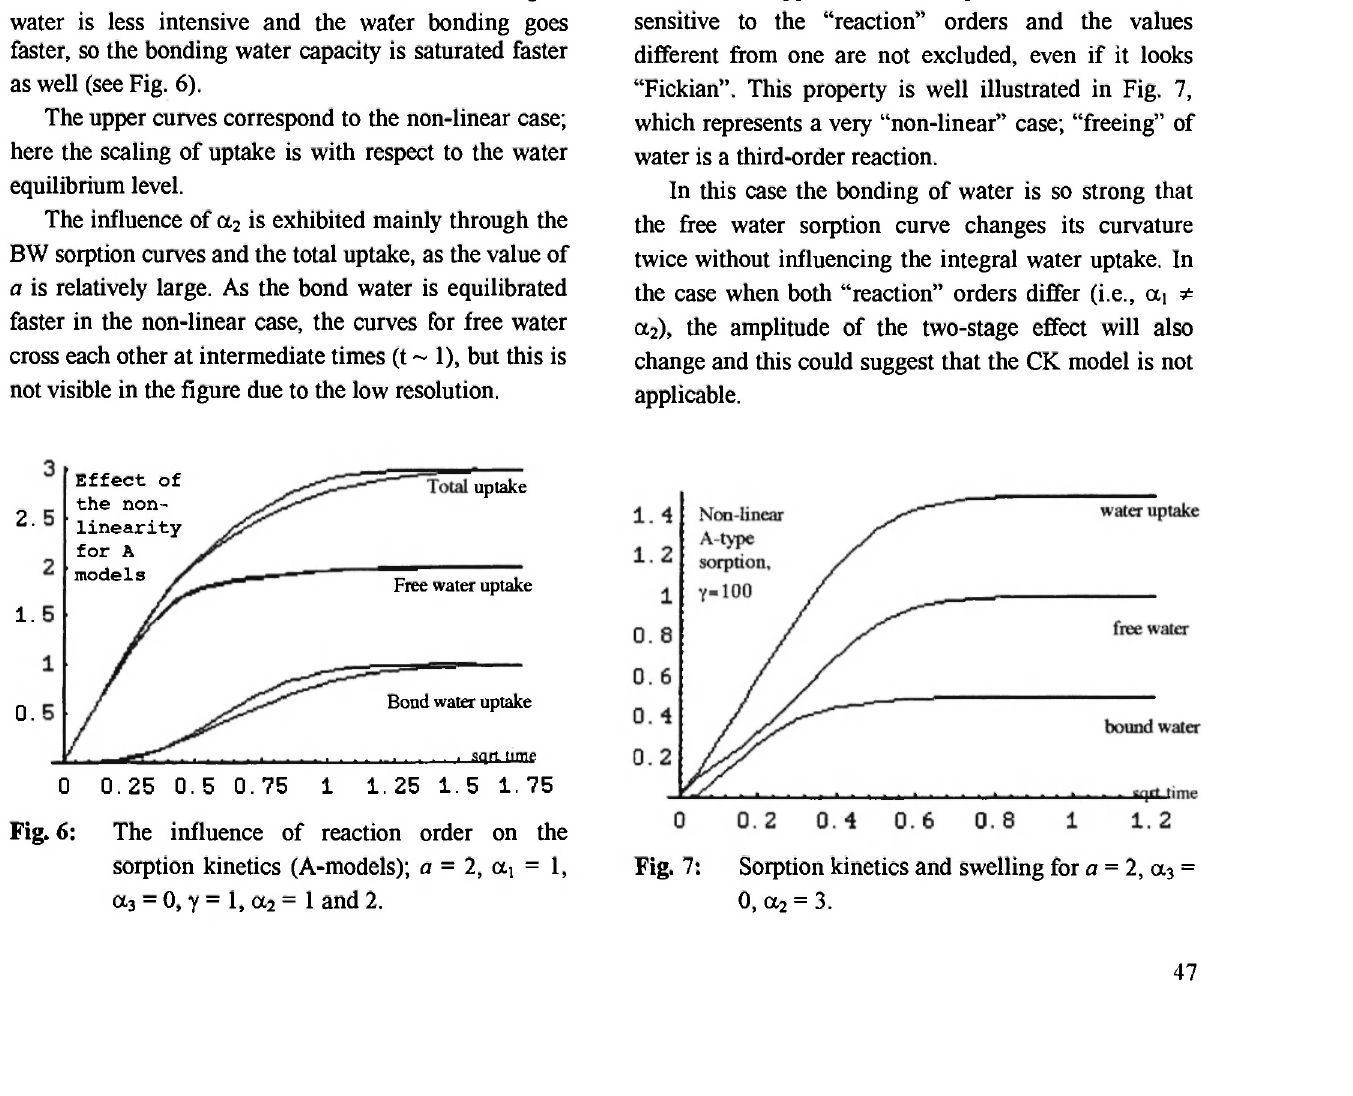
Fig. 6: The influence of reaction order on the sorption kinetics (Α-models); a = 2, αϊ = 1, α 3 = 0, γ = 1, α 2 = 1 and 2.